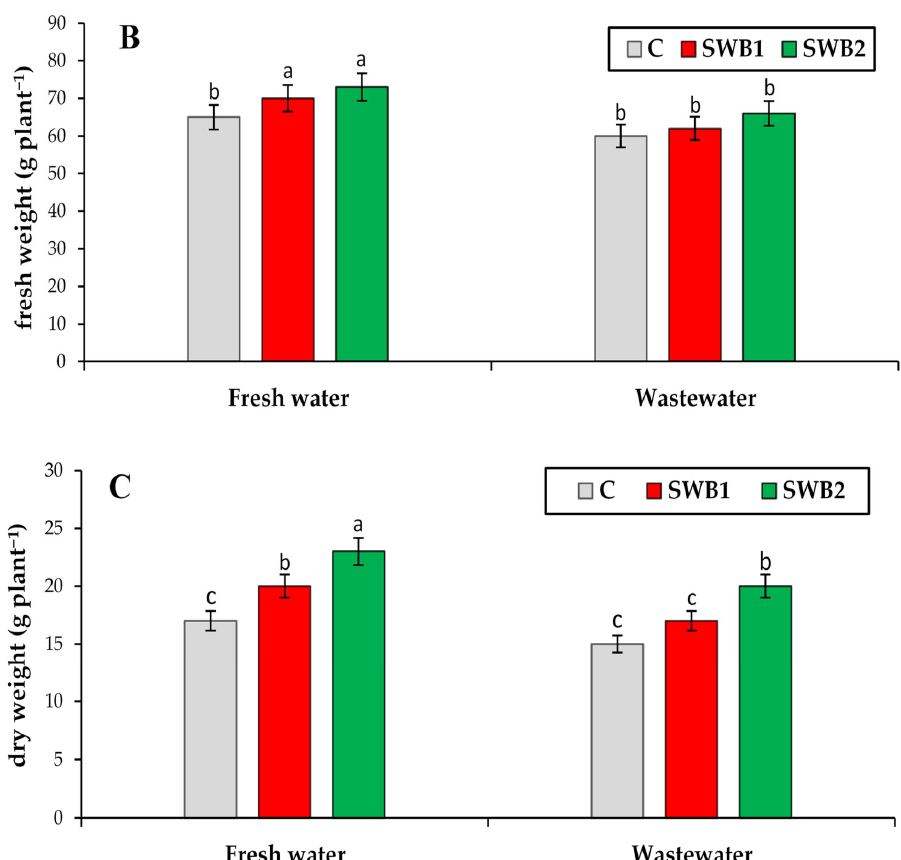
Figure 3. Effect of shrimp-waste-derived biochar (SWB) rates in the growth of quinoa. C, SWB 1 , and SWB 2 are 0, 1, and 2% ( w / w ) of biochar. ( A ) plant height, ( B ) fresh weight, and ( C ) dry weight. Means (±SD, n = 5) with different letters indicate significant differences.